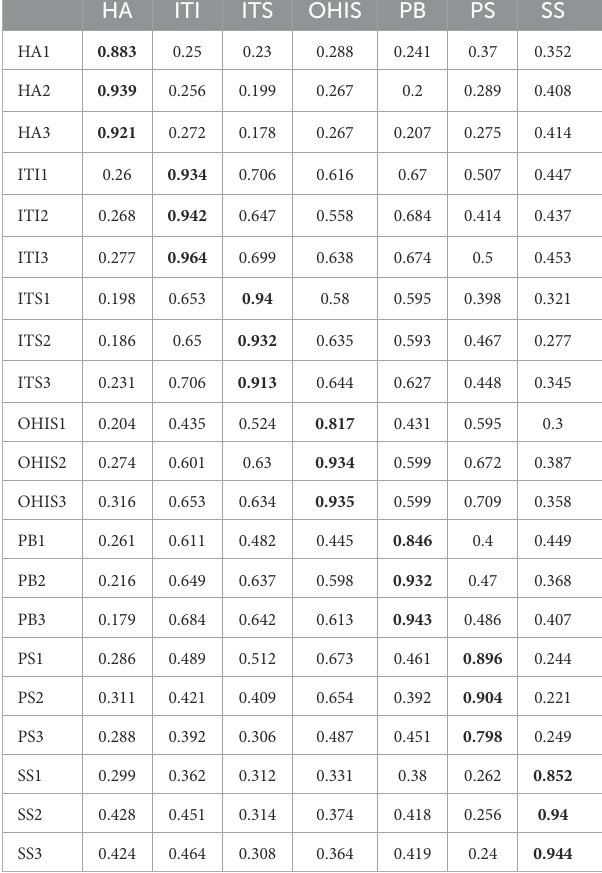
TABLE 3 Loadings and